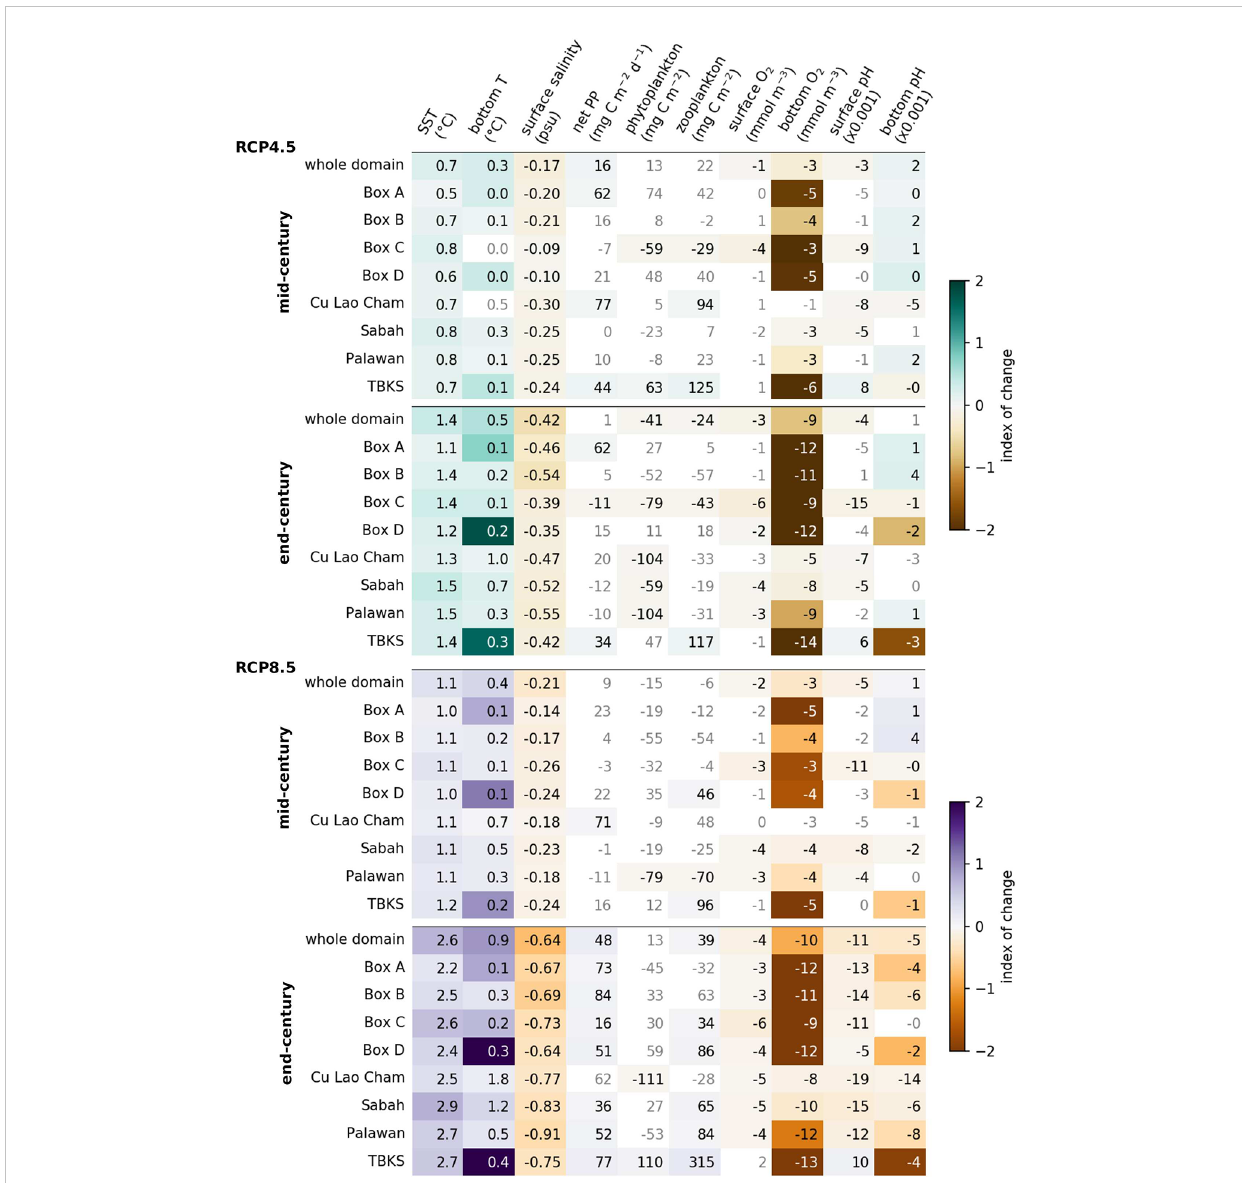
FIGURE 9 Summary of projected change in selected variables under RCP4.5 (above) and RCP8.5 (below), for the whole domain and sample areas shown in Figure 1. In each case the upper part shows change at mid-century (2040-2059 compared to 2000-2019), the lower part shows end-century change (2079-2098 compared to 2000-2019). Values for primary production, phytoplankton and zooplankton are totals for the water column. Text in grey means the change is not statistically signi fi cant. The index of change shows how large the change is compared to the present-day range of monthly mean